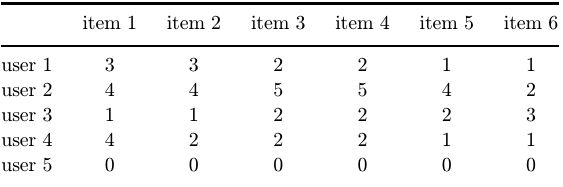
Table 7. Example of the one-phase imputed rating